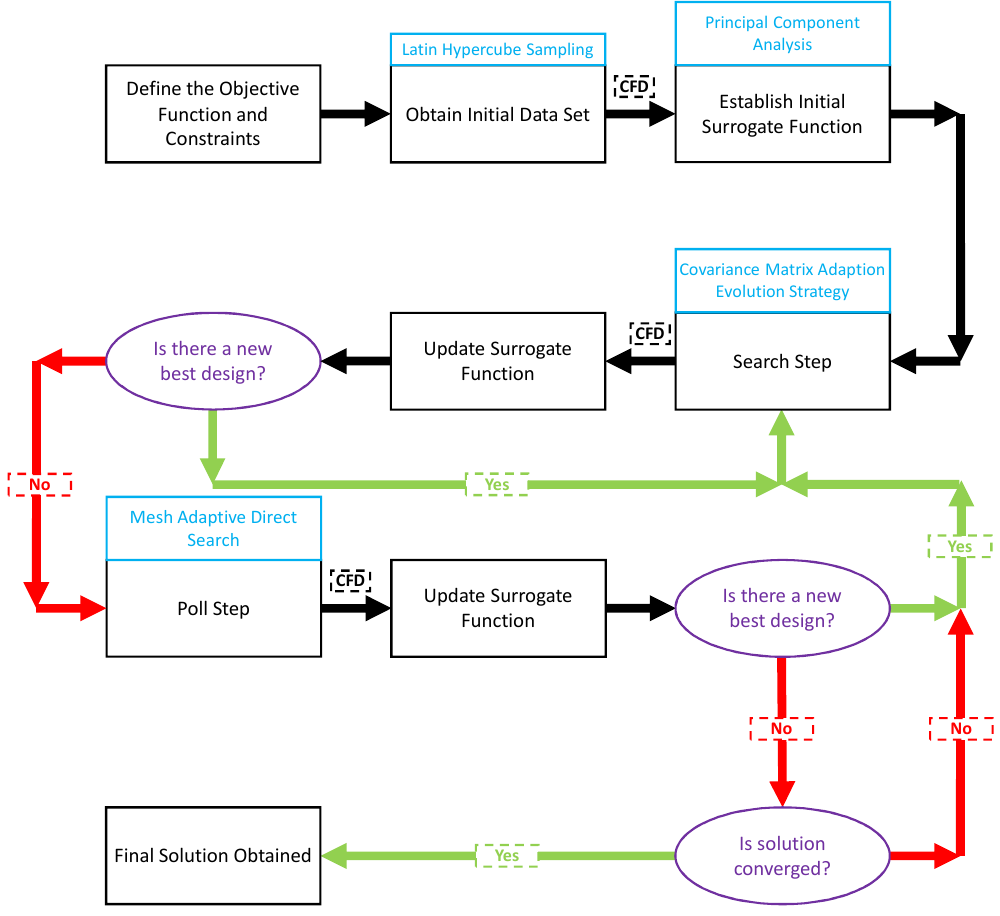
Figure 3. Flowchart of the SMF